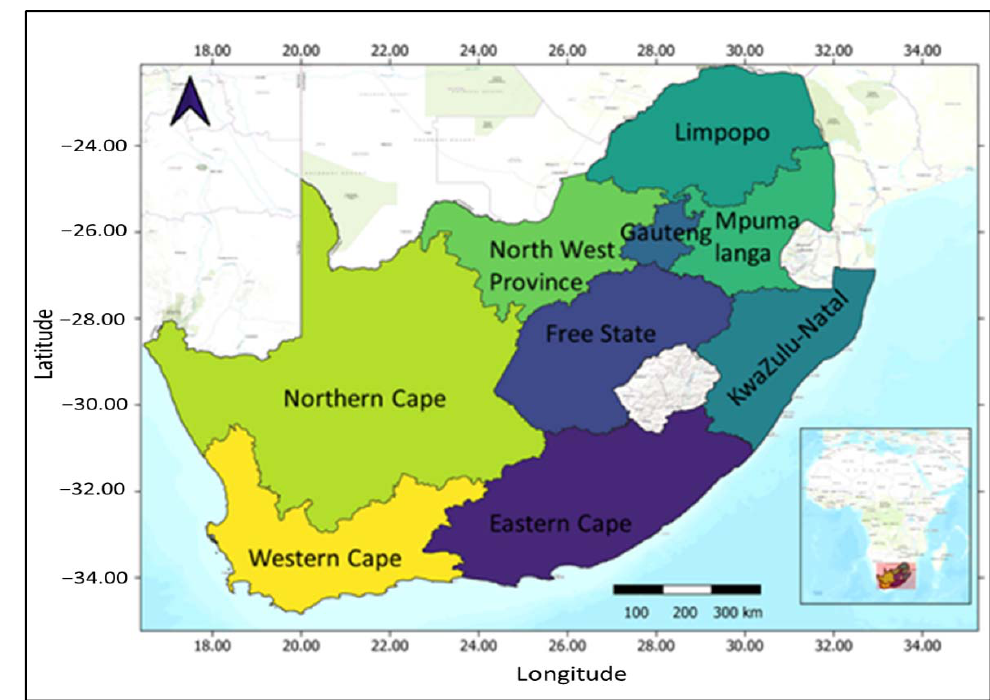
Figure 1. Map of South Africa showing the 9 provinces. The inset map shows the location of South Africa in the map of Africa.